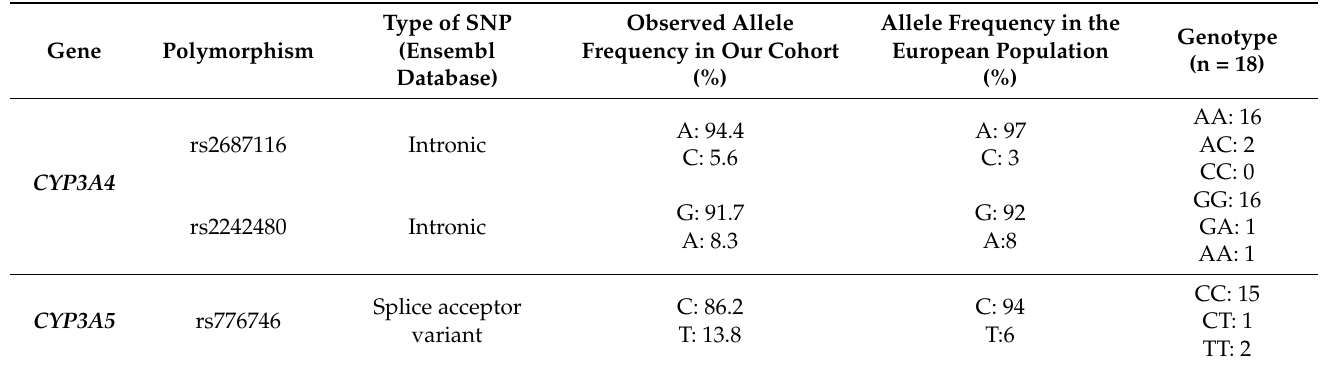
Table 3. SNPs analyzed in the cohort of patients with advanced thyroid